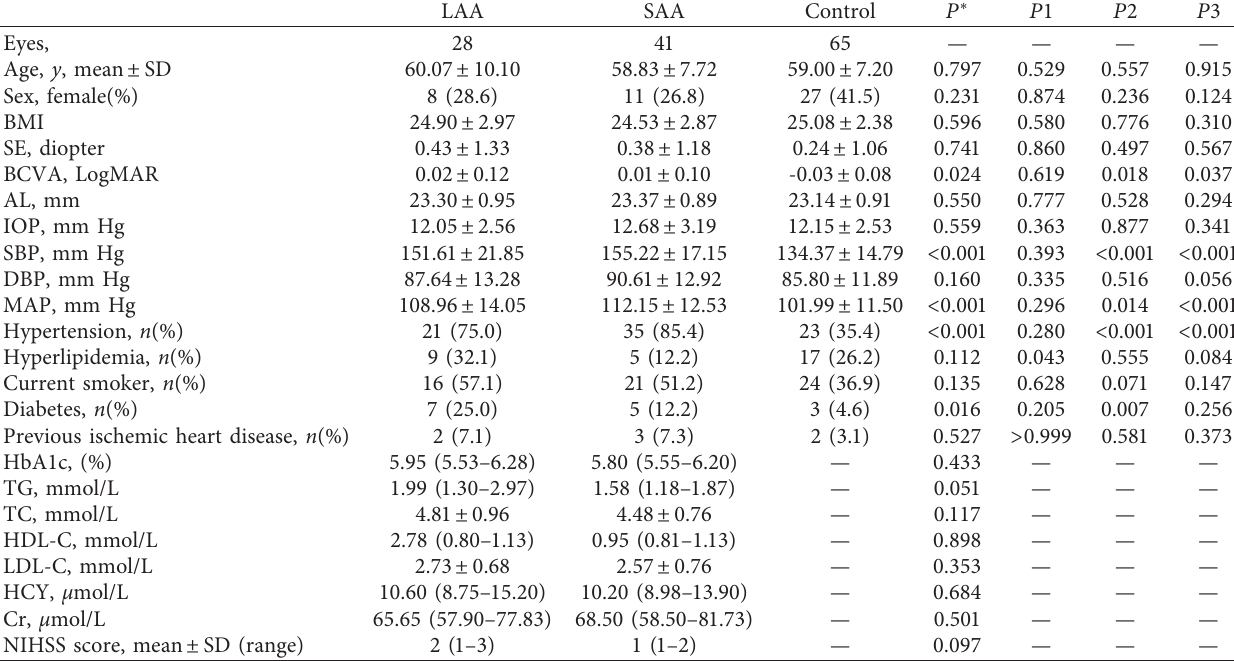
Table 1: Demographic characteristics of study